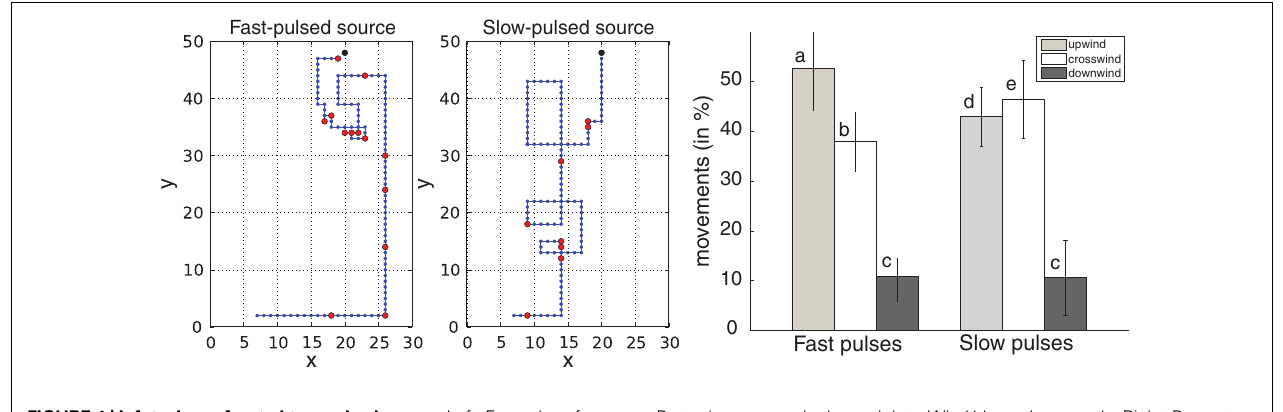
FIGURE 4 | Infotaxis confronted to a pulsed source. Left: Examples of simulated infotactic trajectories with incorrect modeling by the searcher. The searcher considers a continuous source model whereas the actual source is pulsed (fast and slow pulsed conditions). Source location indicated as a black dot is (20,49). The searcher initial location is (6,3).